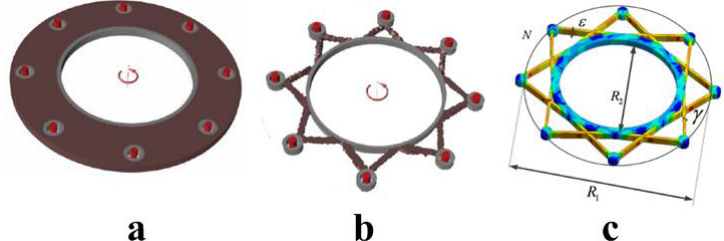
Figure 10. The original flange model ( a ), flange framework obtained by topology optimization ( b ), stress distribution of flange frame ( c ).